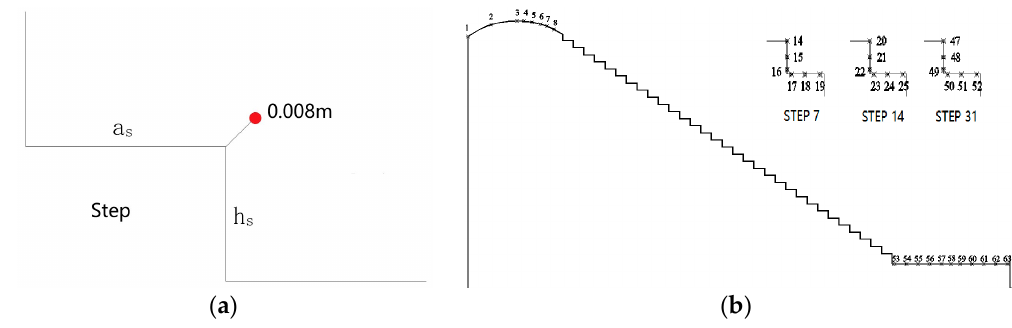
Figure 9. Experimental data gauging points along the spillway for the 31-step case: ( a ) Velocity point; ( b ) Pressure point.